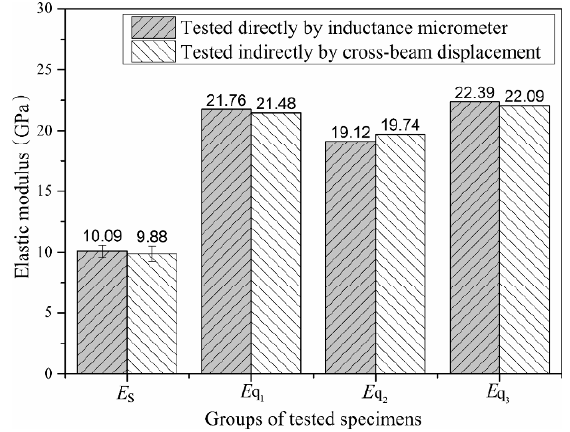
Fig. 9 Elastic modulus of graphite substrates and SiC/graphite composites at room temperature measured by three-point bending